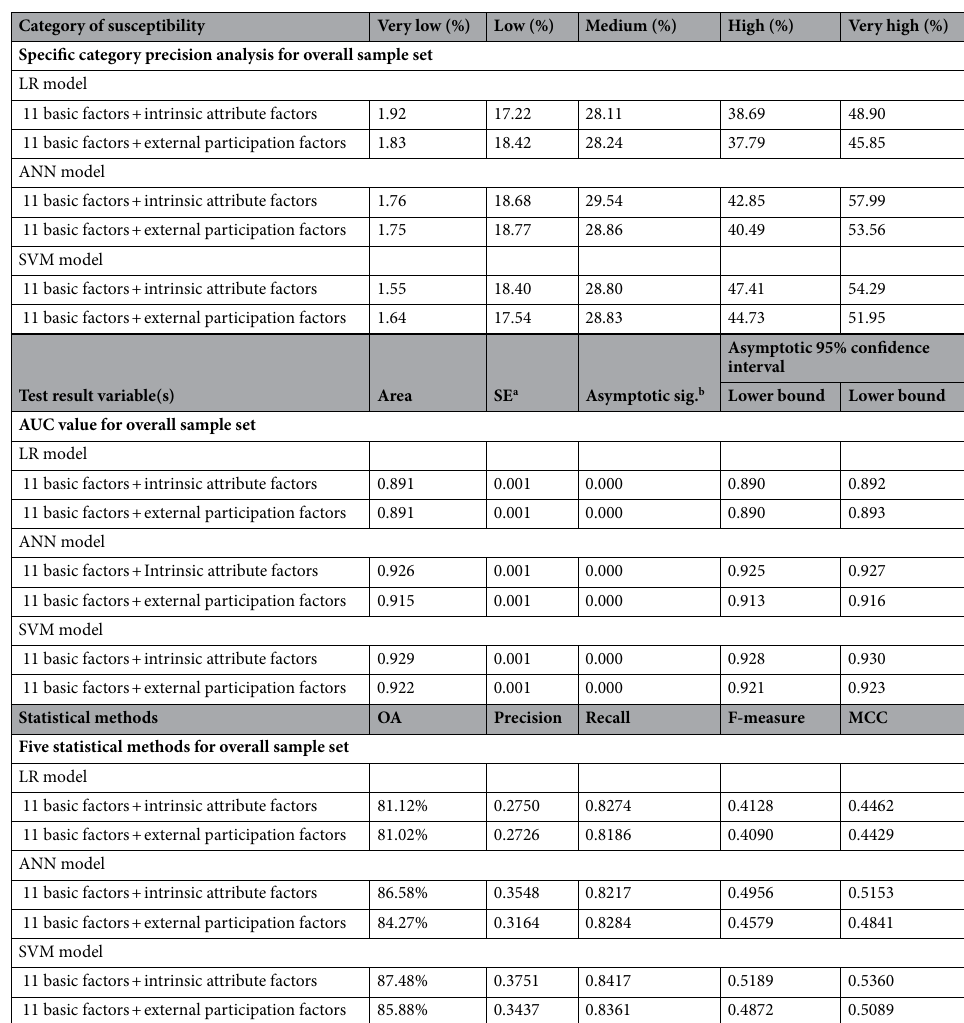
Category of susceptibility Very low (%) Low (%) Medium (%) High (%) Very high